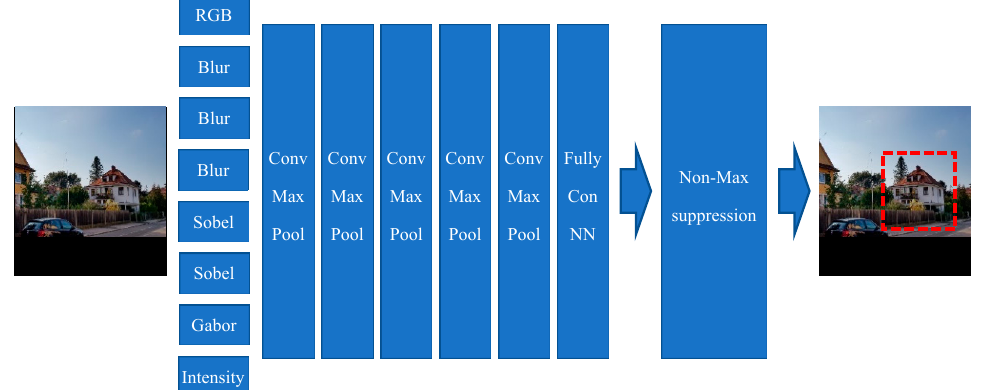
Figure 12. House detection model based on a convolutional neural network. The output of the boxeswithhousesimilarityof95%willbeselectedforNon-Maximumsuppressionwith0.65overlapping